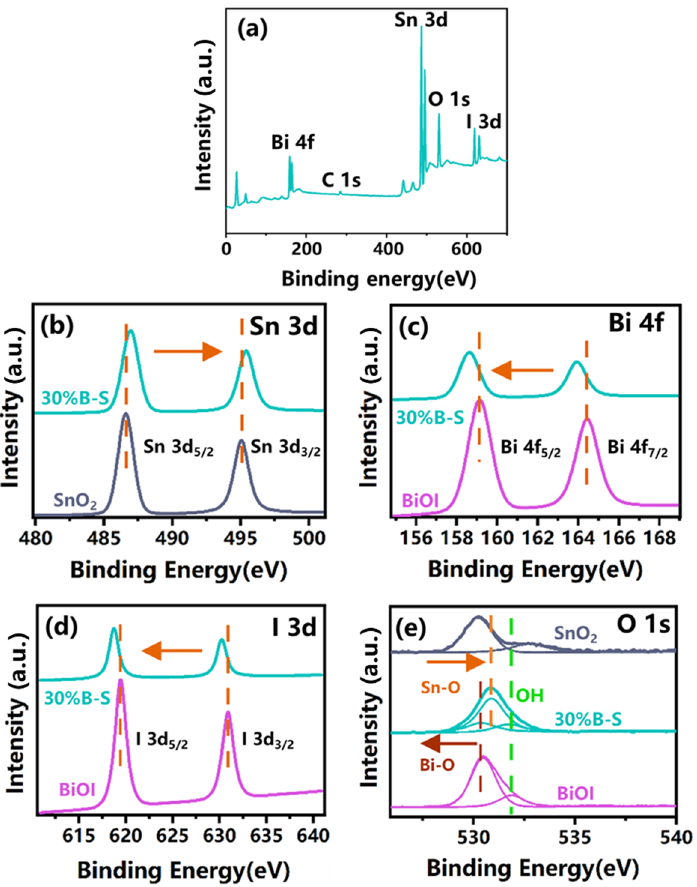
Figure 4. XPS survey spectrum of ( a ) 30%B-S. High-resolution XPS spectra of ( b ) Sn 3d, ( c ) Bi 4f, ( d ) I 3d, and ( e ) O 1s for BiOI, SnO 2 , and 30%B-S.